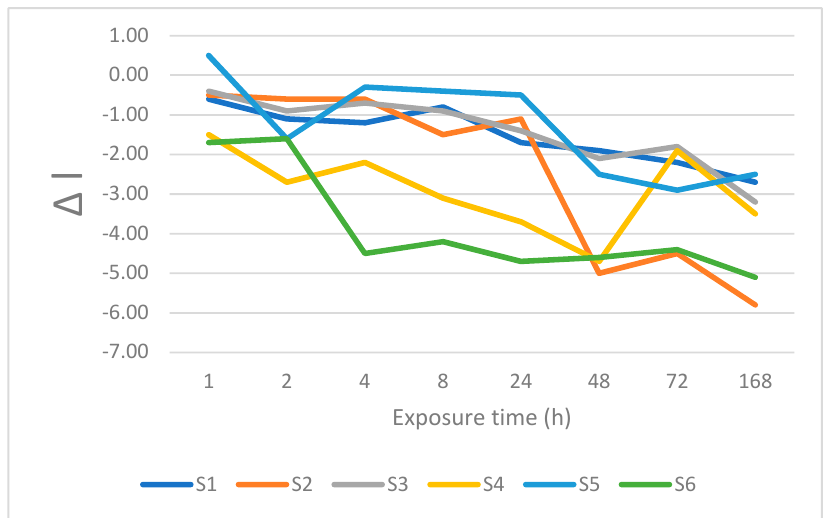
Figure 5. Changes is lightness after immersion in sweetened tea.